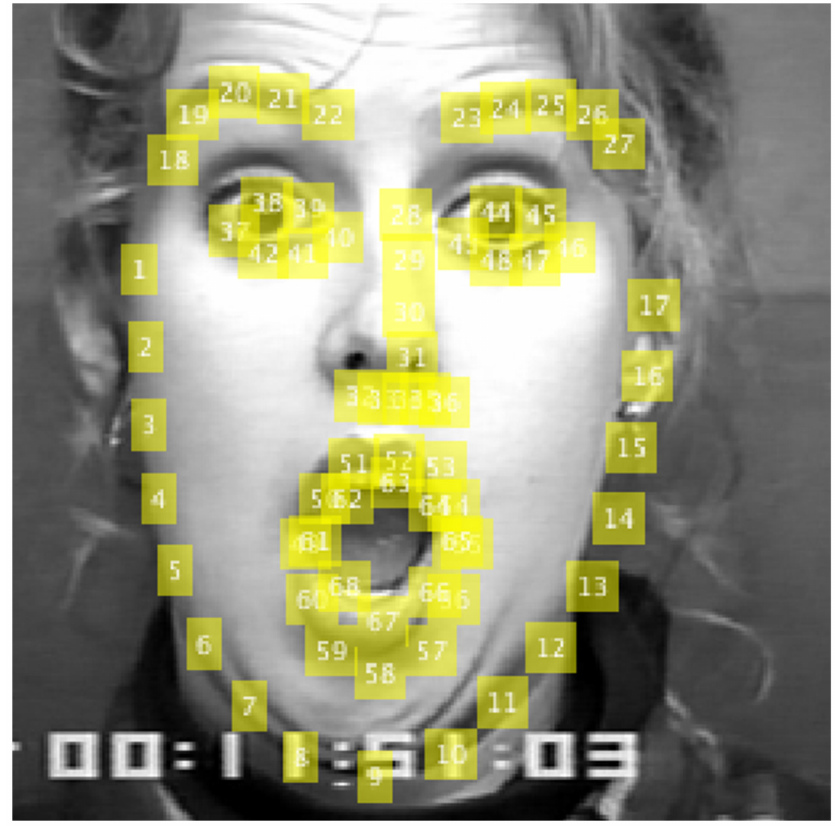
Figure 2. The 68 landmarks used in our work. Each landmark is marked with its number. Original image extracted from BU-3DFE